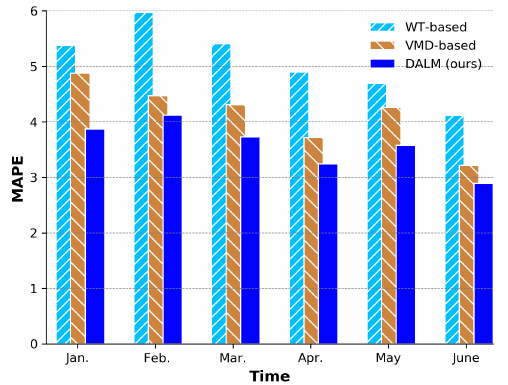
Figure 10. Forecast errors with different decomposition algorithms. The data from the UGI in 2019.